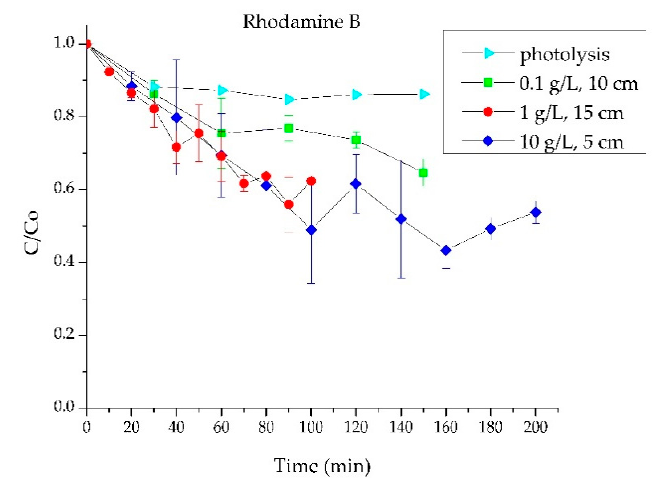
Figure 8. Degradation curves of Rhodamine B for different amounts of catalyst and irradiation time, under visible light irradiation. Photolysis of the pollutant is also included.